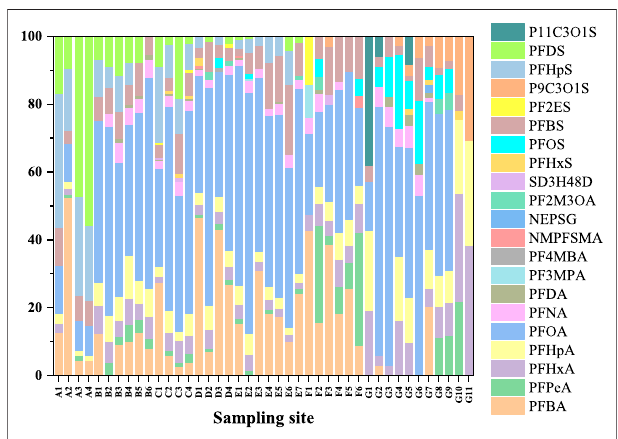
FIGURE 1 | Composition pro fi le of PFASs in 7 reservoirs.